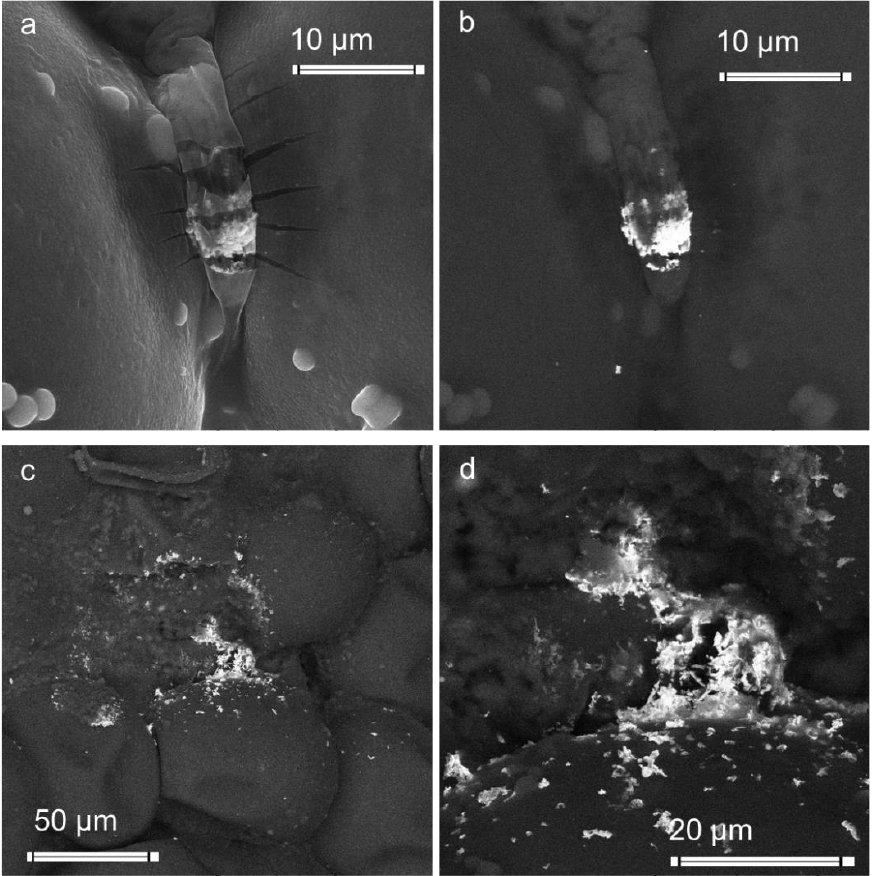
Figure 6. Fine and ultrafine gold PM found on the pollen surfaces. ( a ) Secondary electron micrograph of corn pollen contaminated by gold particles. ( b ) Corresponding backscattered electron (BSE) micrograph of corn pollen, highlighting bright spots that correspond to gold particles. ( c ) BSE micrograph showing PM of gold scattered on several pollen grains. ( d ) Higher magnification of gold PM on pollen grains showing the presence of fine and ultrafine PM.